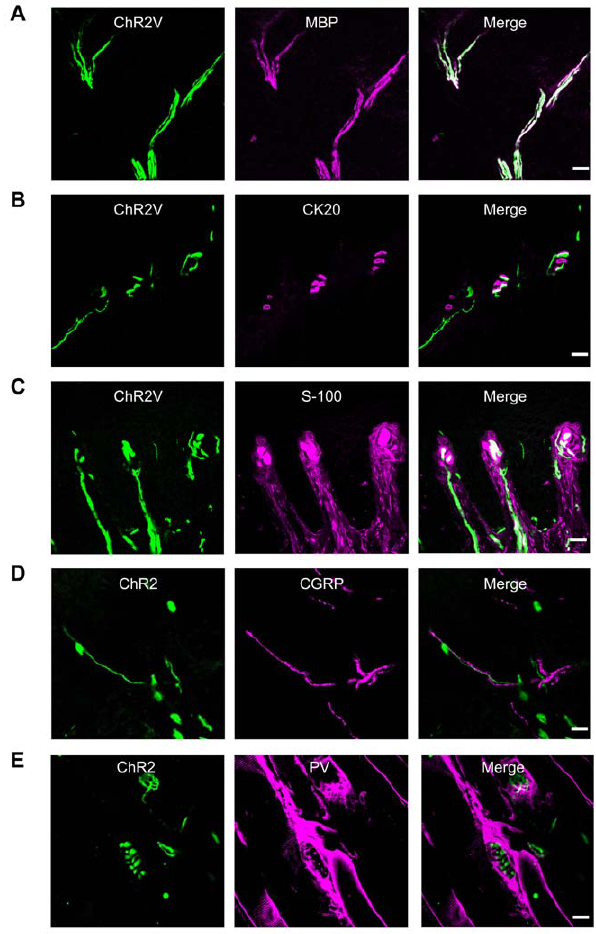
Figure 4. Distribution of ChR2V in the peripheral sensory nerve endings. A–D. Immunohistochemical identification of the ChR2V + nerve endings in the skin in relation to MBP (A), CK20 (B), S-100 (C) or CGRP (D). E. Co-localization of the ChR2V + nerve endings with PV in the muscle spindle. Scale bars indicate 20 m m.